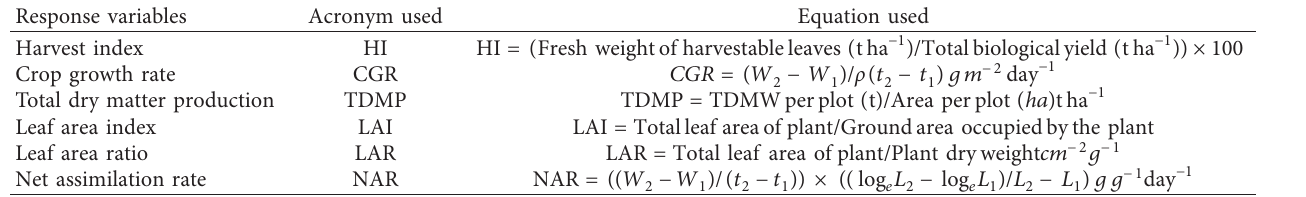
Table 1: Response variables measured in the